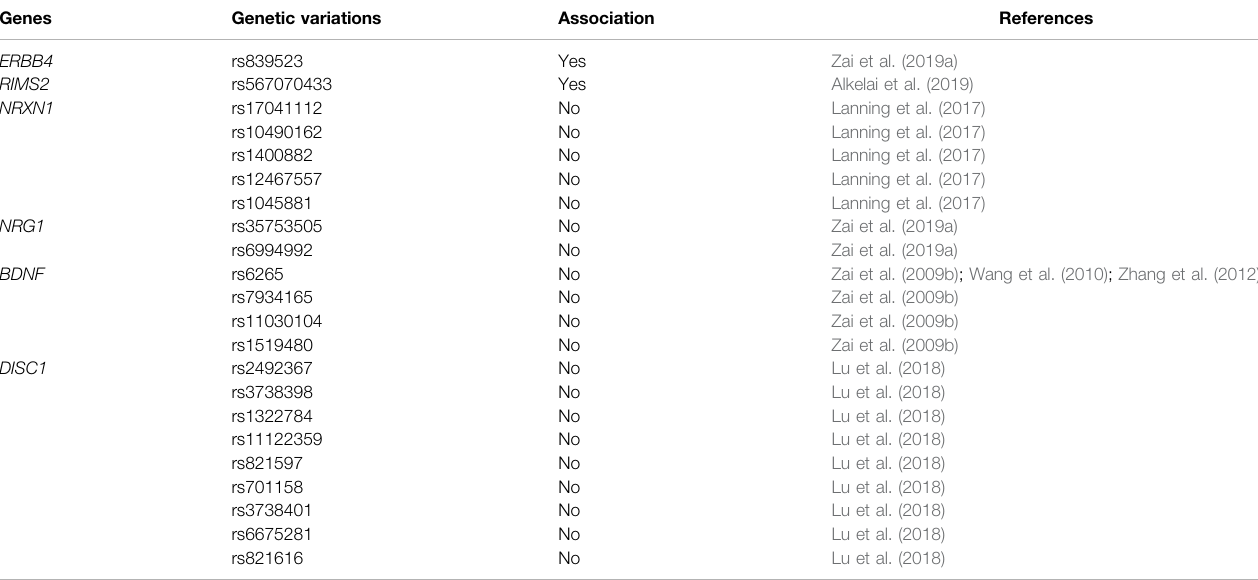
TABLE 7 | Developmental and plasticity: genetic variations and associations with TD. Genes Genetic